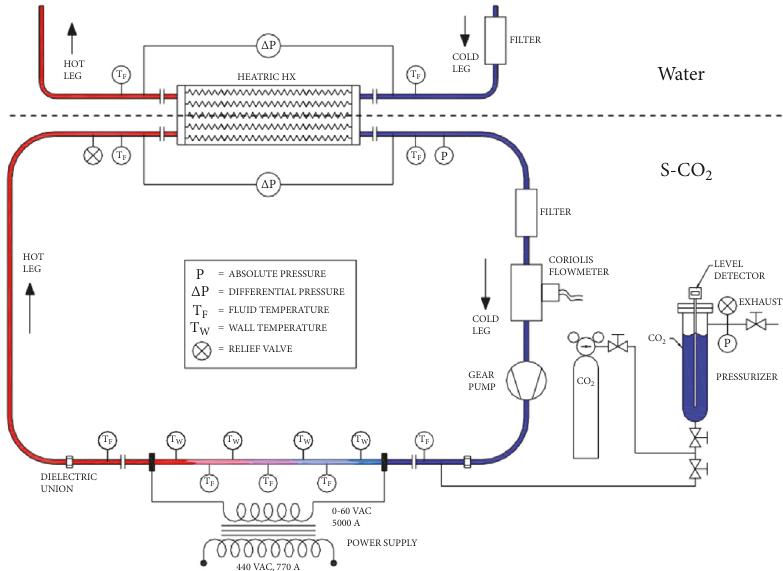
Figure 5: Schematic diagram of the experiment loop [33].